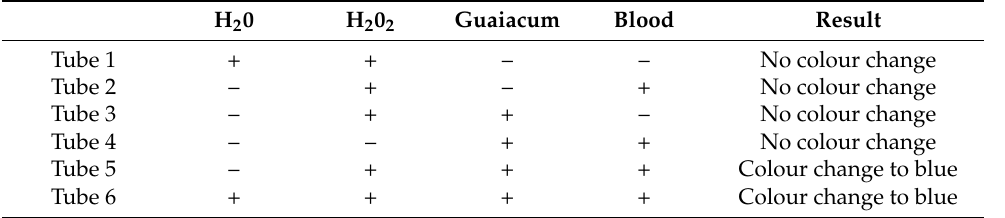
Table 1. Test to demonstrate guaiacum powder colour change when in contact with hydrogen peroxide and blood.